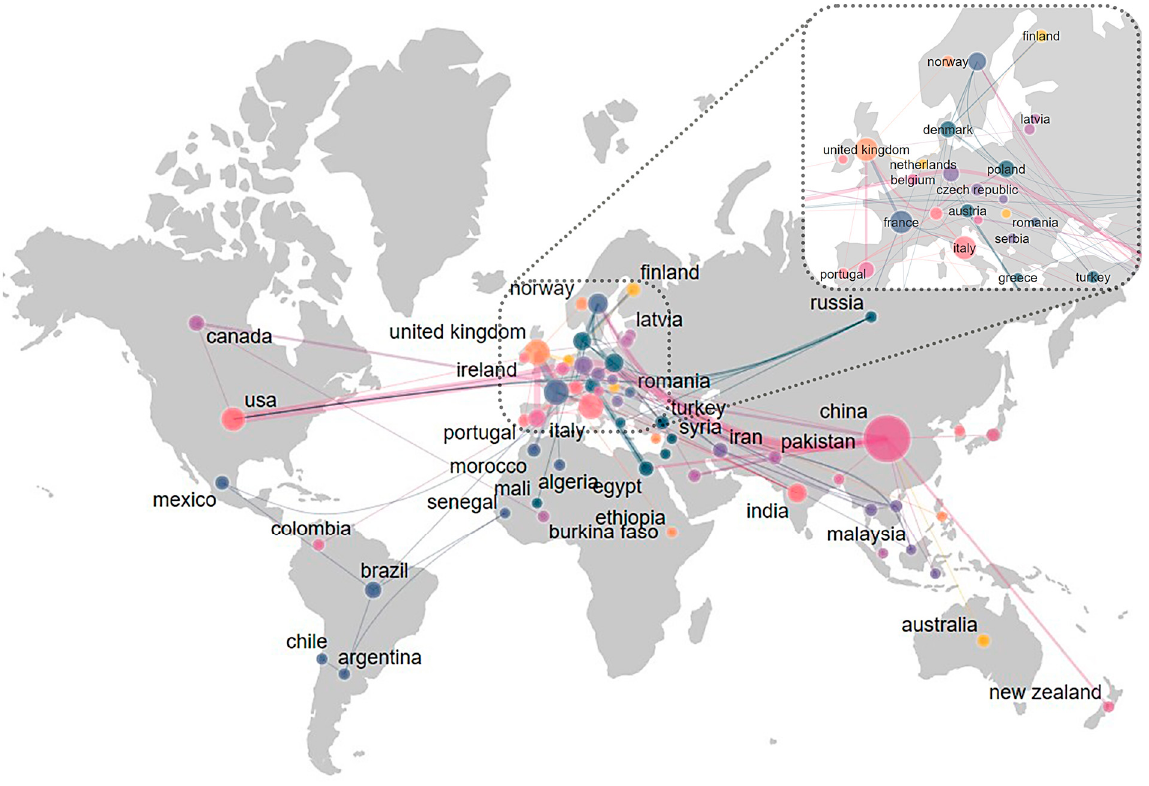
Figure 4. Visual map of collaboration by country/region.